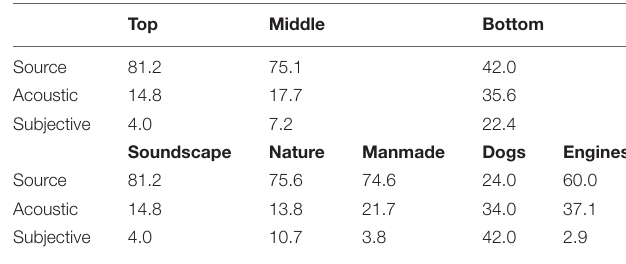
TABLE 3 | Percentages of different types of descriptive words used at each level of the taxonomy and for each type of